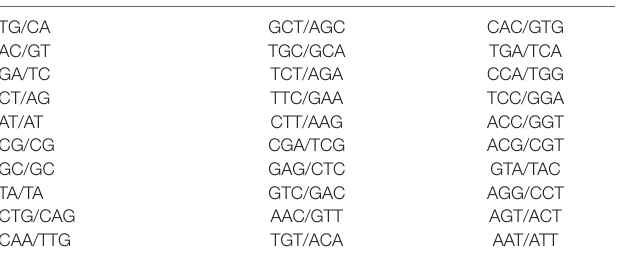
TABLE 1 | Common SSR motifs found across all the Phytophthora